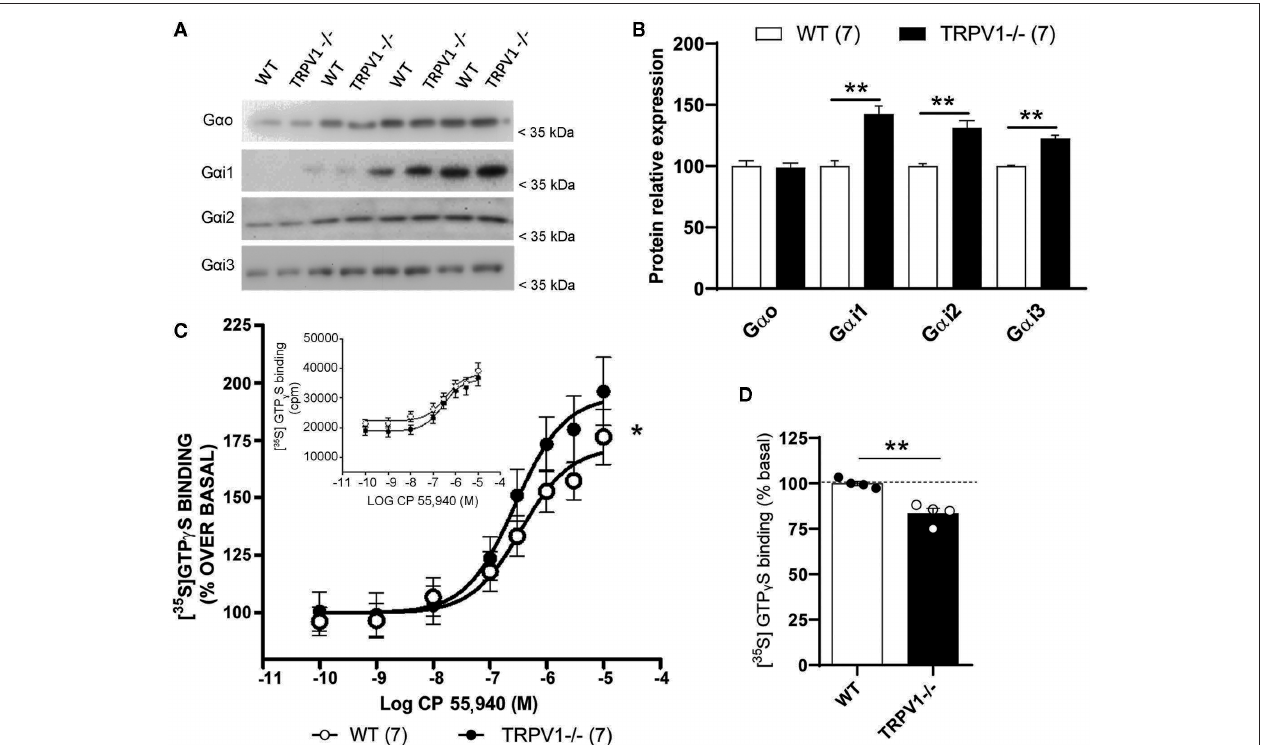
FIGURE 4 | Molecular changes in G α o and G α i subunits in TRPV1-/-. (A,B) Immunoblot and relative expression of G α o , G α i1 , G α i2 , and G α i3 proteins in synaptosomal extracts with increasing protein concentrations (4, 8, 12, and 16 µ g/ µ l) from WT and TRPV1-/- mice hippocampi. p > 0.05; * p < 0.05; ** p < 0.005. Data are expressed as mean ± SEM. (C) CP 55,940-stimulated [ 35 S]GTP γ S binding assay in the hippocampal synaptosome fractions from WT and TRPV1-/-. Concentration curves were constructed using mean values ± SEM from four different experiments performed in triplicate. Paired t -test; * p < 0.05. Inset: CP 55,940 concentration–response curves are expressed in cpm (counts per minute) to show non-normalized basal (WT: 22.179 ± 2.844 cpm vs. TRPV1-/-: 18.715 ± 2.816. Paired t -test; * p < 0.05) and E max values (WT: 39.079 ± 2.844 cpm vs. TRPV1-/-: 36.251 ± 2.285 cpm. Paired t -test; ns; p > 0.05). (D) Bar graph representing the relative percentage of [ 35 S]GTP γ S basal binding levels in WT and TRPV1-/-. Unpaired t -test; ** p < 0.005. Data are represented as mean ±